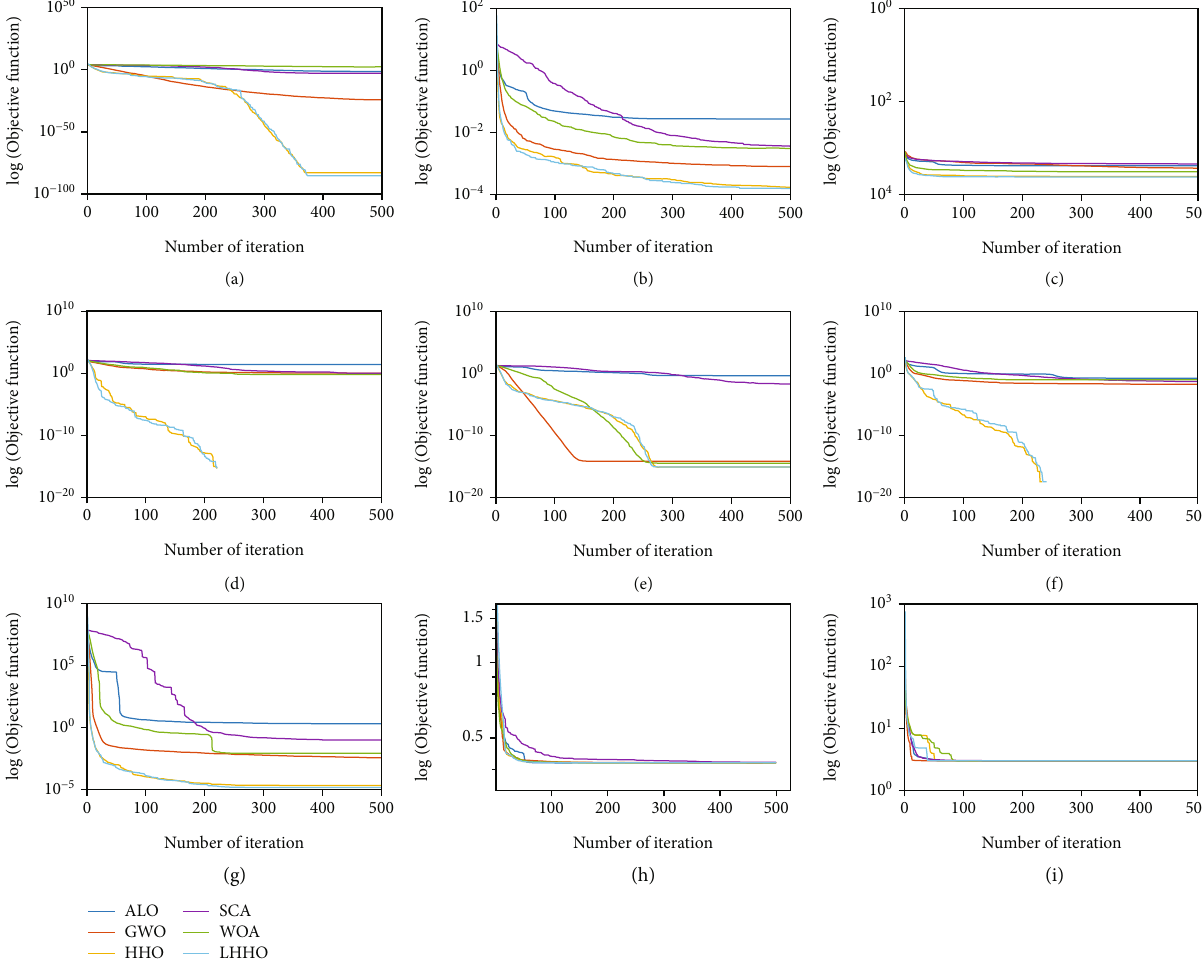
Figure 8: Convergence Curves of a few Benchmark